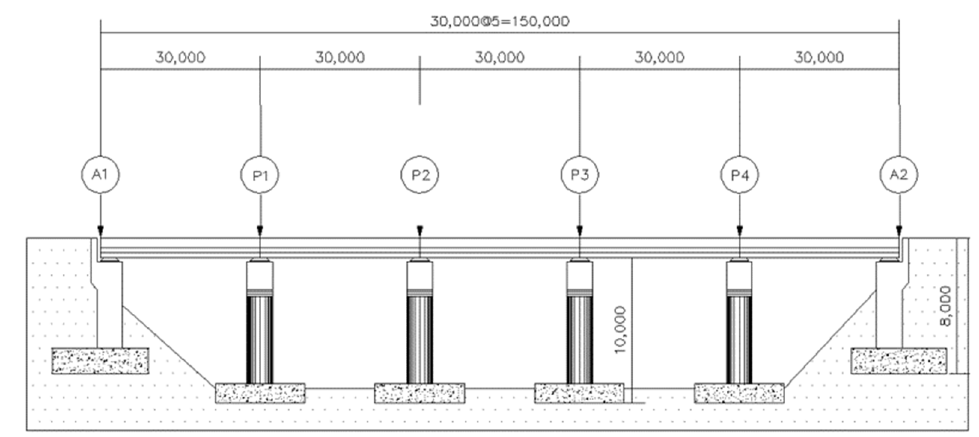
Figure 3. Side layout of the bridge.